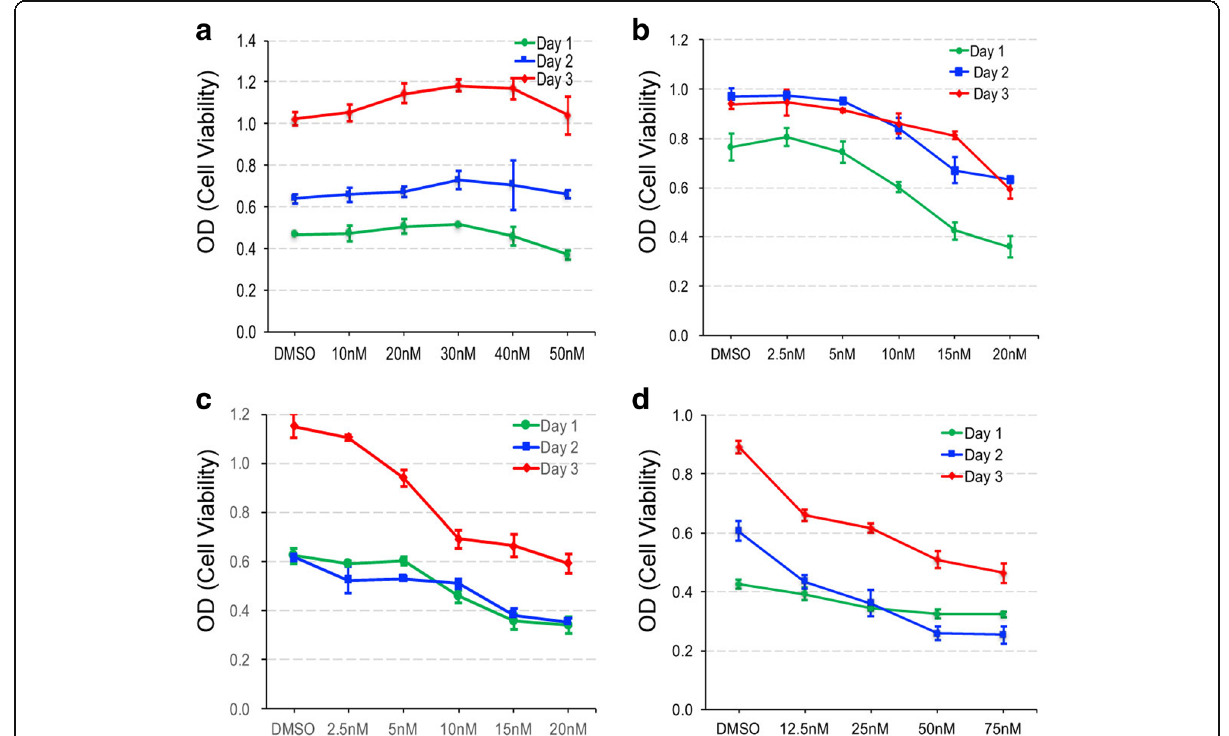
Fig. 1 AA induces a dose - dependent growth inhibition in pancreatic cancer cells. Panel a shows data obtained from HEK 293, ( b ) from CAPAN-2, ( c ) from BXPC-3, and ( d ) from PANC-1 cells. Label on the X-axis indicates treatment with various concentration of AA in nM or DMSO as control. Data was analyzed from three samples at 24, 48 and 72 h after initial treatment. Error bars indicate standard deviation (SD). P value between DMSO control and various doses of AA was <0.05. P value between each day was also <0.05 ( b , c , d